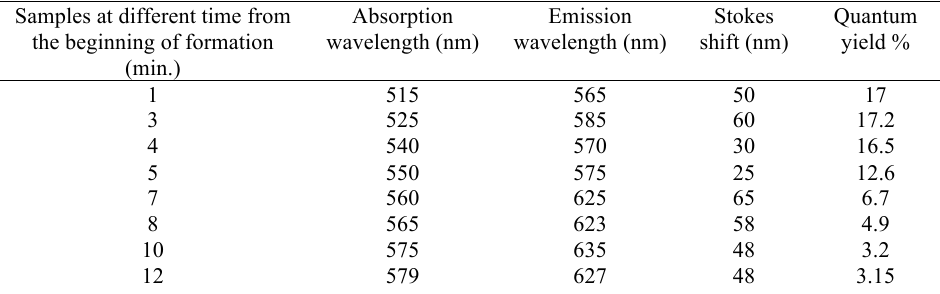
O /CdSe nanostructures (samples 3 4